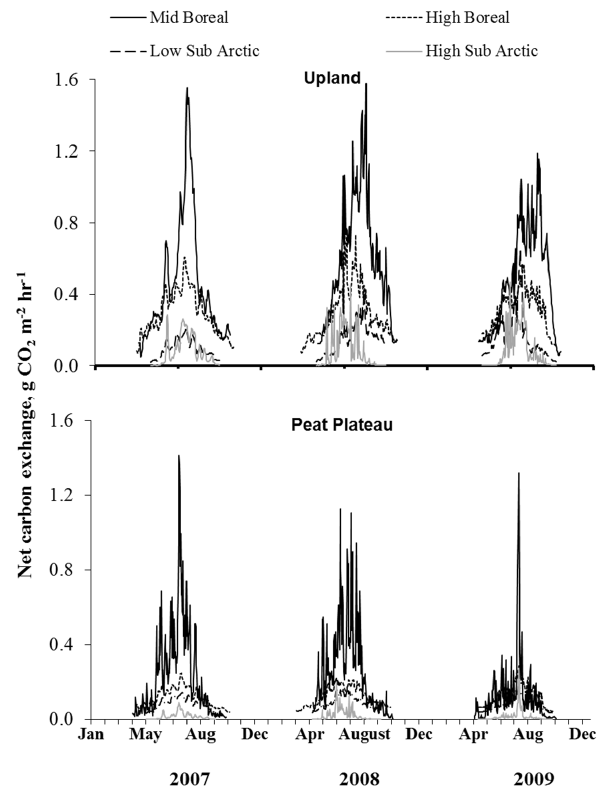
Figure 5. Temporal variation in net carbon exchange (NCE) for different landforms at sites within different ecoregions.